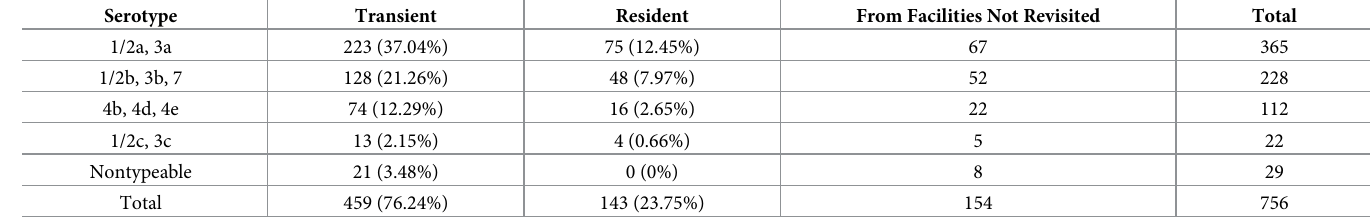
Table 2. Distribution and classification (i.e., resident, transient, from facilities not revisited) of strains across L . monocytogenes serotypes. Percentages are relative to the total number of Transient and Resident strains. Serotype